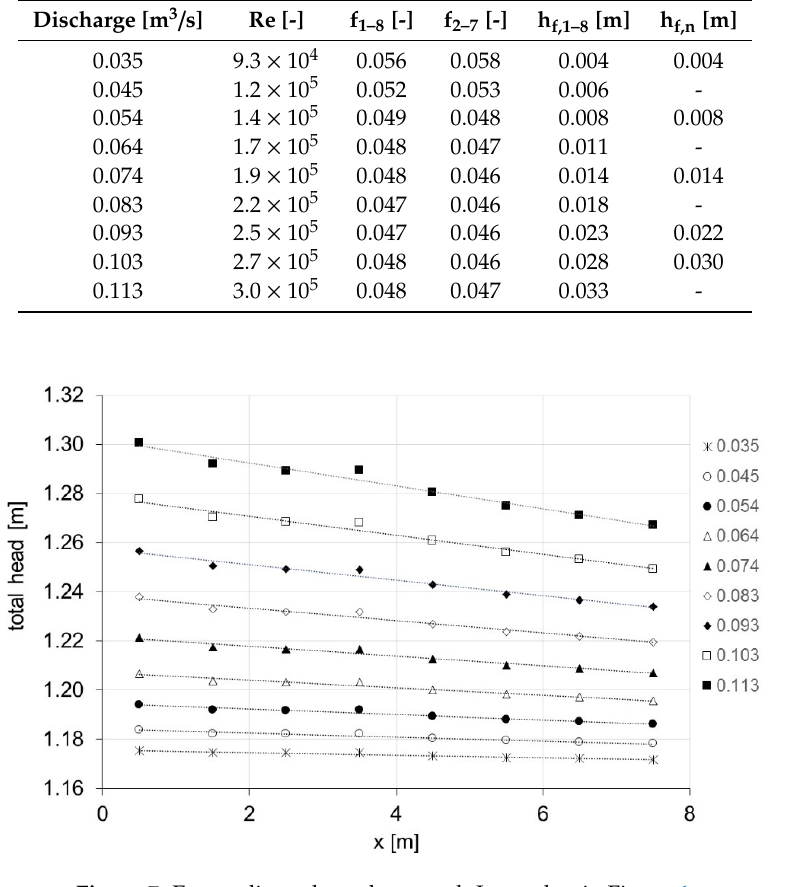
Figure 7. Energy lines along the tunnel. Legend as in Figure 6.